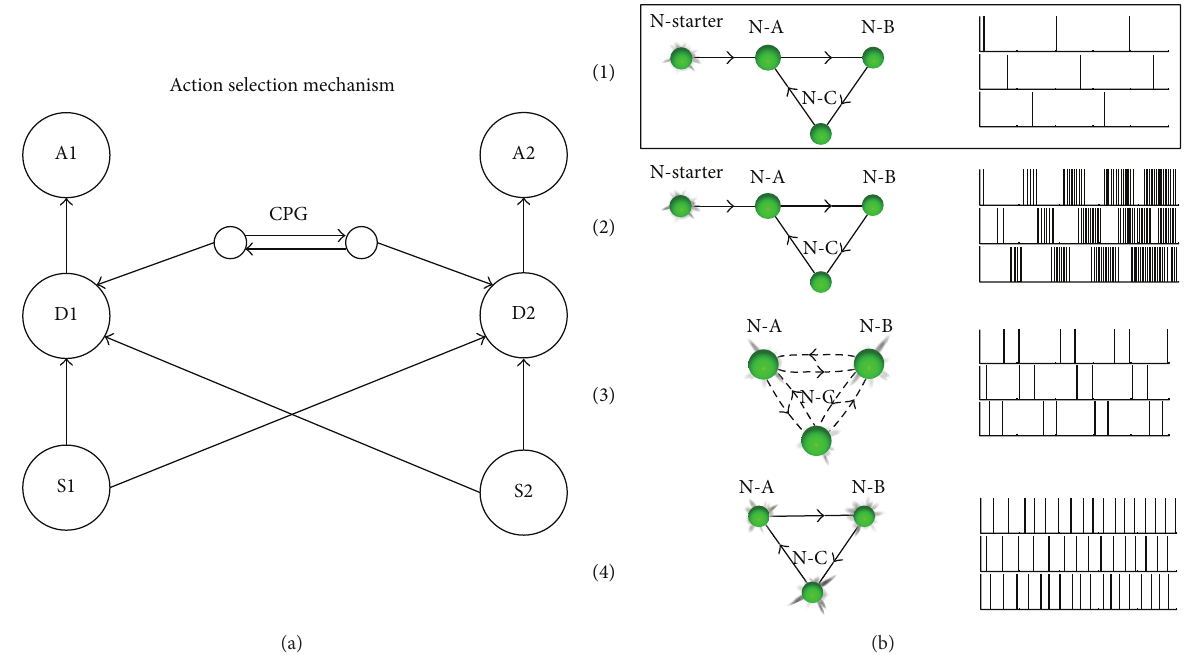
Figure 1: Dynamic of the AS mechanism and CPG topologies. (a) First, a stimulus is perceived from a sensory neuron. Then, the spikes emission from the sensory neuron targets all decision neurons, conserving a neutral aspect in the choice of possible actions to come. Finally, when the sensory input coincides with the CPG input at the decision neuron, the linked action will be performed (alternatively switching between actions). (b) In (1), the CPG represents the serial circular excitatory topology we used in this work. In (2), we show one option among several possibilities of tuning differently the internal neural parameters such as the postpotential state value, the refractory period, and the length of the neural curves. In (3), we show an all-to-all reciprocal inhibitory CPG circuit built with endogenous pacemaker neurons. In (4), we still keep the pacemaker neurons in the CPG but it is now linked with excitatory synapses. Overall, (b) (comparative spike bars in the same time scale on the right side) demonstrates the diversity of the output patterns reflected in different CPG, derived from small structural and functional